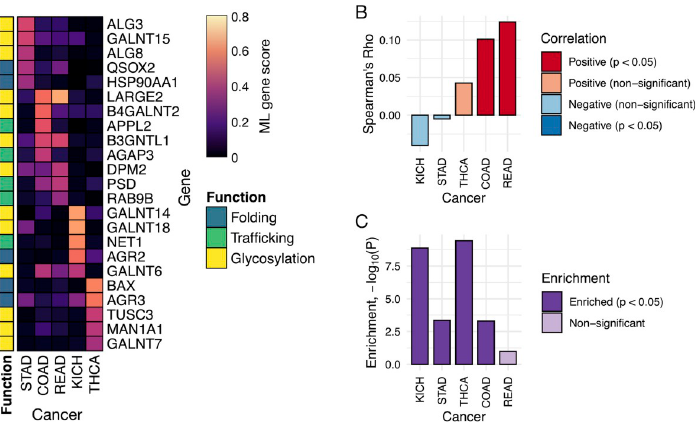
Fig 4. Glycosylation is an enriched function among the top PSP genes associated with a subset of cancer types. ( A ) The heatmap shows the consensus ML gene scores of the cancer types for which 3 out of 5 top-scoring genes encode for glycosylation activity. The colorbar to the left of the heatmap indicates the function associated with each gene. ( B ) Spearman correlation of secretome gene expression fold-changes (normal vs. tumor) with the total number of N- and O-linked glycosylation sites present on those genes. Negative and positive correlations are colored in blue and red, respectively, with darker colors shown for correlations with p < 0.05. ( C ) Enrichment of highly glycosylated proteins among significantly differentially expressed secretome genes between normal and tumor samples. Shown are the log- transformed p-values obtained from the hypergeometric test, where darker colored bars represent cancer types for which p <